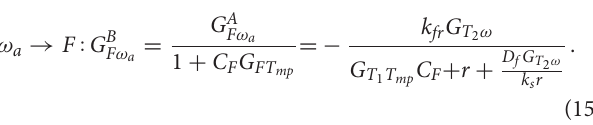
were considered suitable parameters for the active cable-driven robotic